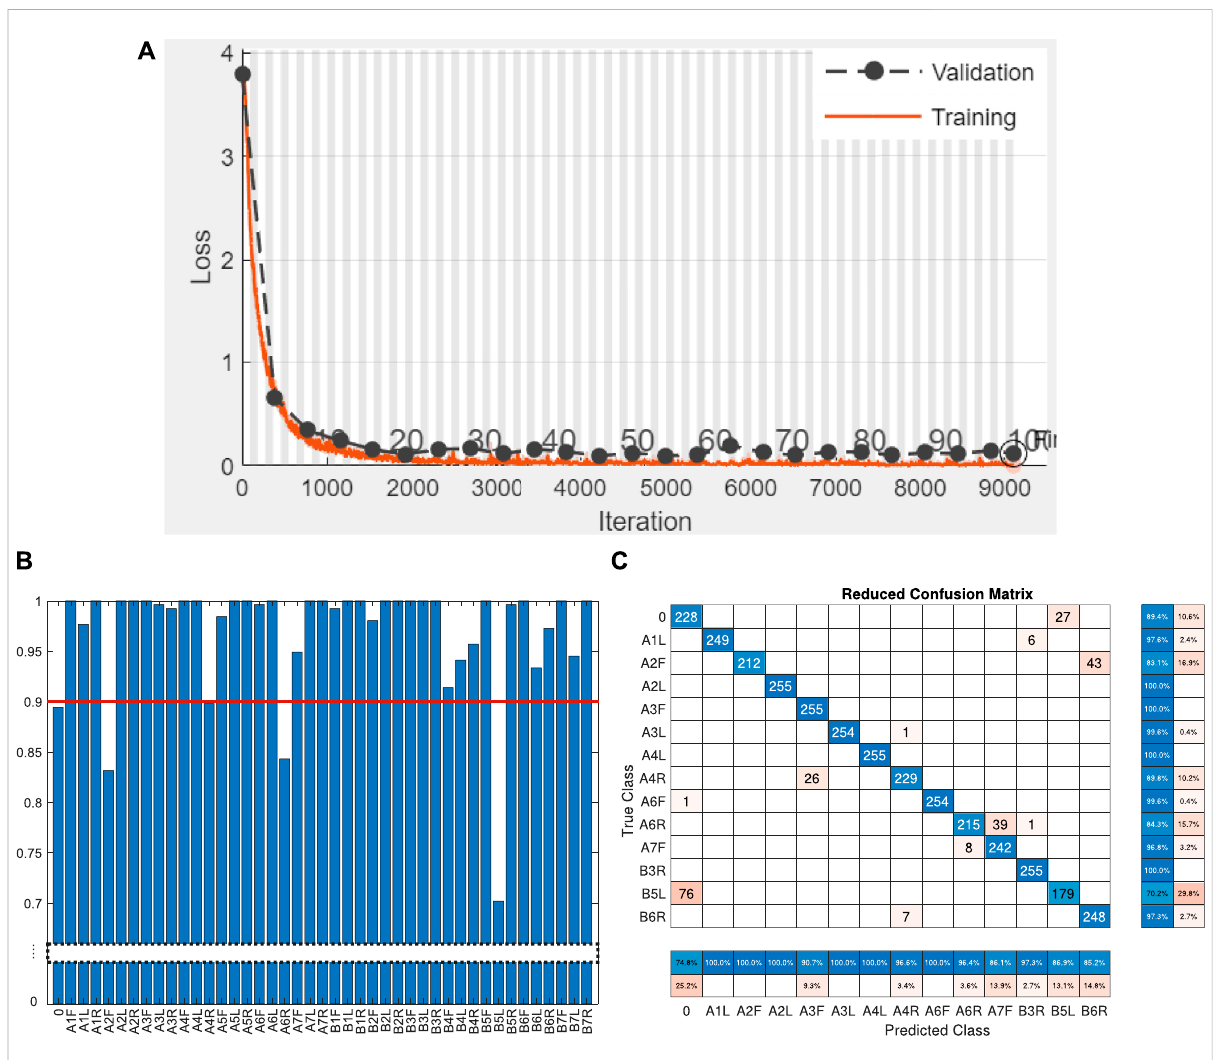
FIGURE 8 (A) Training progress of the biLSTM network. The validation is performed using unseen data during training, which we also use for testing (see Section 3.2). Damage localization results. (B) Classi fi cation results for 43 individual damage con fi gurations. The red line indicates the threshold used toreducethenumberofclassesintheconfusionmatrixin (C) . (C) Reduceconfusionmatrix.Onlydamagecon fi gurationswithclassi fi cationaccuracy up to 90% are presented to increase readability. The original 43 × 43 confusion matrix is sparse as much damage exhibits a near-perfect classi fi